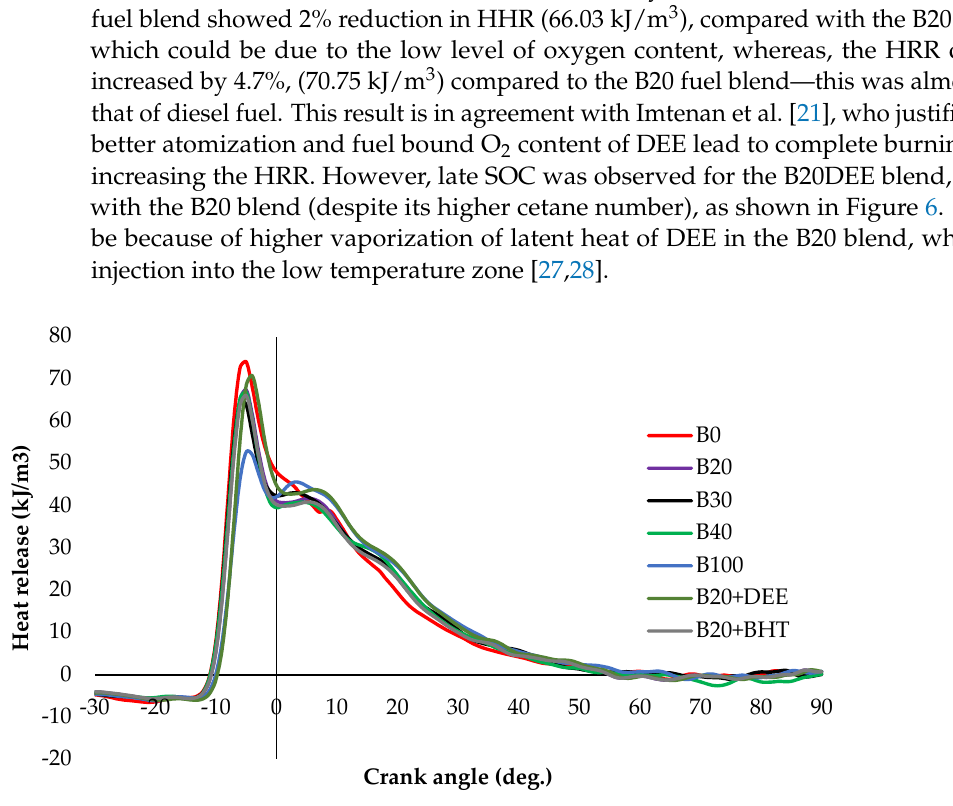
Figure 6. HRRs of all fuel blends at full load.